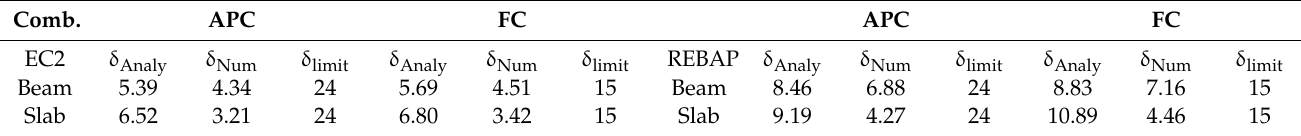
Table 8. Deformation and limit values of the 2NLM for the first case of study (values in mm). Comb.